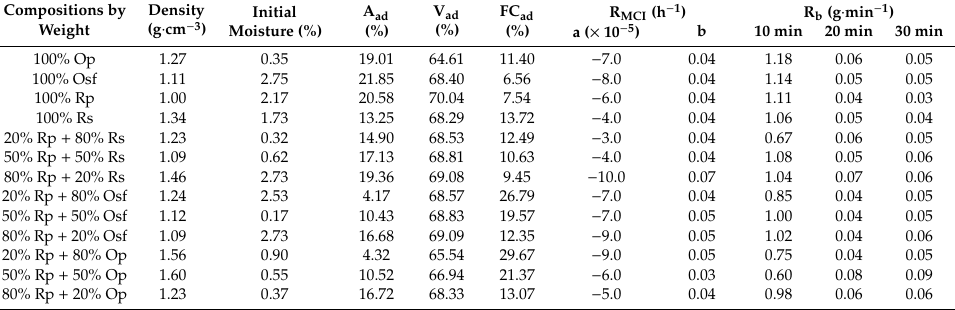
Note: The repetition levels of density, A ad , V ad , and FC ad were